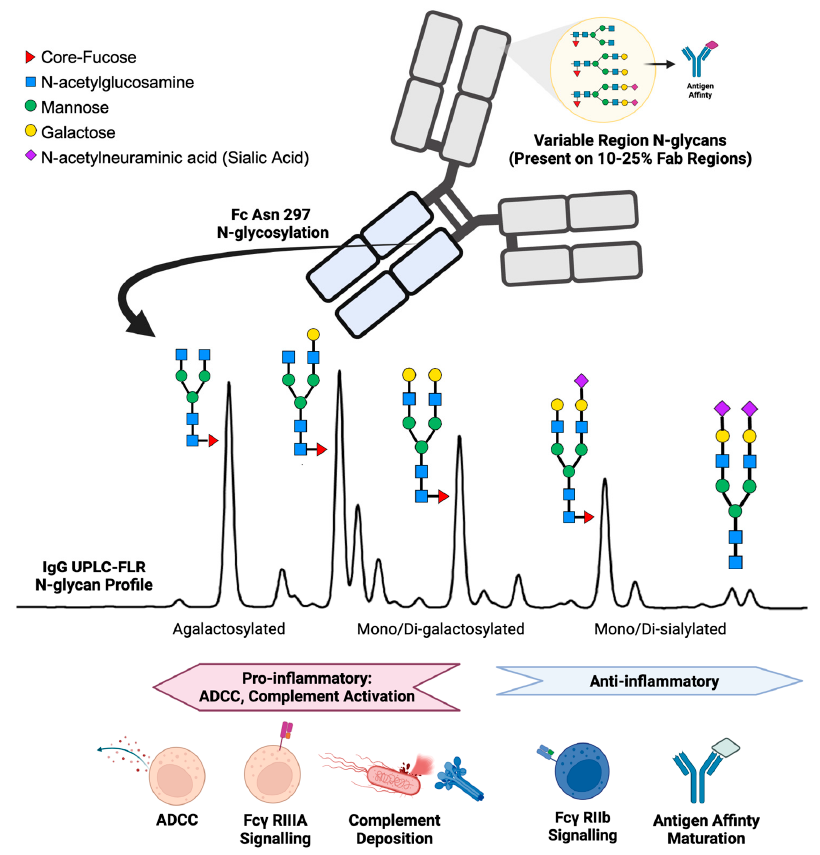
Figure 1. Summary of IgG N-glycan present on the variable region (Fab) and the constant heavy chain tail region (Fc) with associated immunologic